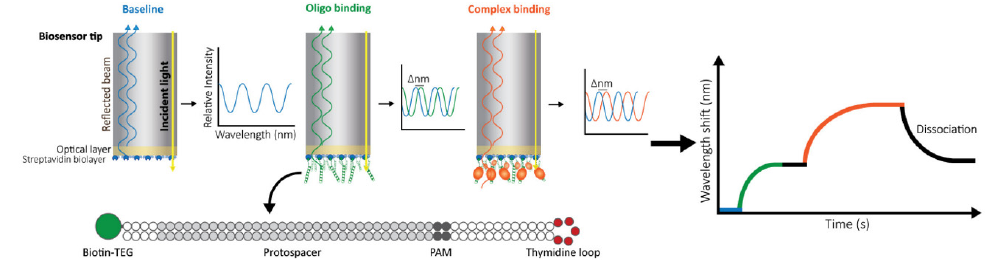
Figure 13. Real-time detection using the tip immobilization procedure. Reproduced from Open